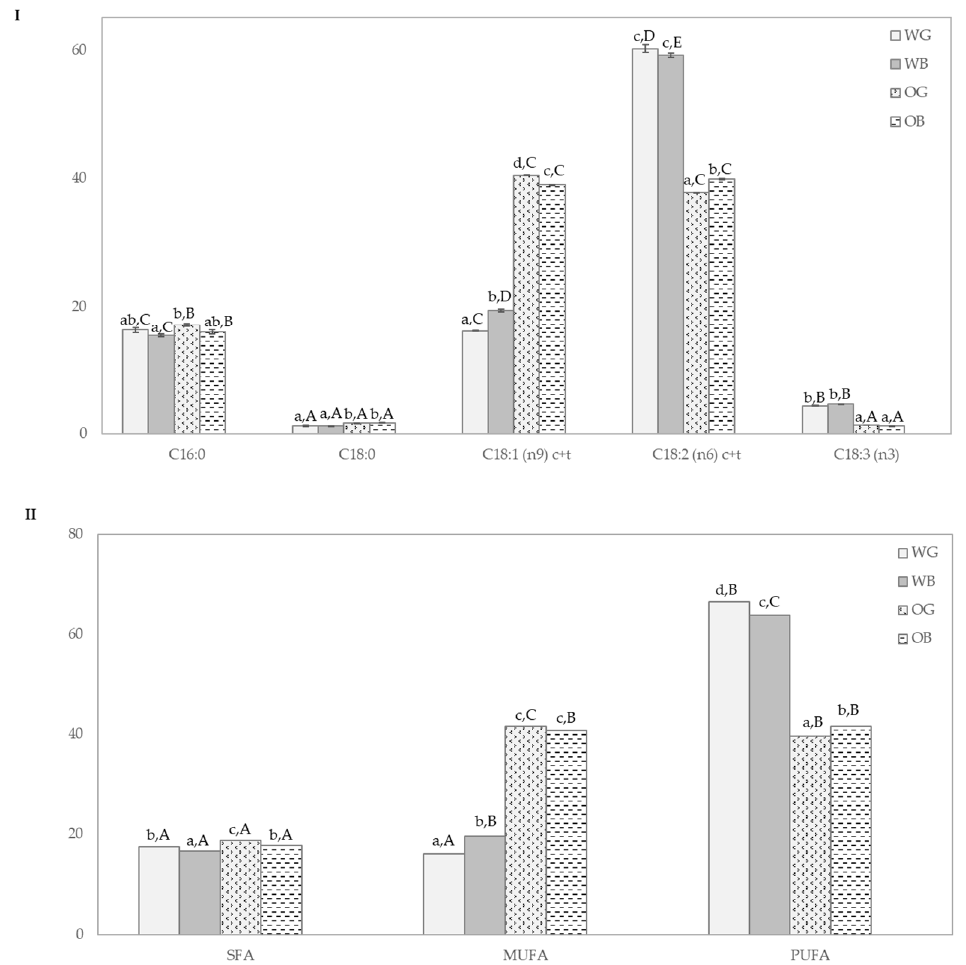
Figure 2. Fatty acid profile of wheat grain (WG), oat grain (OG), wheat bran (WB), and oat bran (OB). ( I ) More abundant fatty acids: palmitic (C:16:0), stearic (C:18:0), oleic (C:18:1(n9)), linoleic (C:18:2 (n6)), and α -linolenic acids (C:18:3 (n3)) and ( II ) Fatty acid groups: saturated fatty acids (SFA), monounsaturated fatty acids (MUFA) and polyunsaturated fatty acids (PUFA). Results were expressed as % of total fatty acids. Different lowercase letters indicate significant differences ( p < 0.05) in a given fatty acid among samples (WG, WB, OG, and OB) and capital letters indicate significant differences ( p < 0.05) in a given sample (WG, WB, OG, or OB) among fatty acids ( p < 0.05).